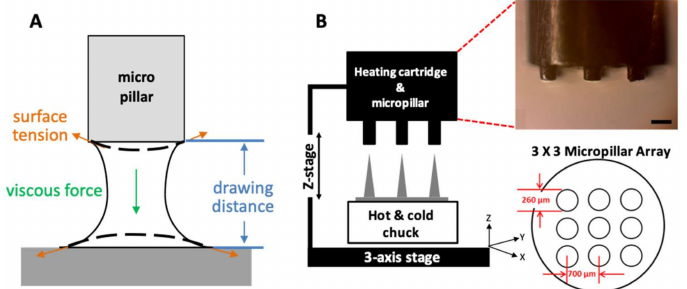
Figure 1. ( A ) A schematic image of phenomenological variables, including surface tension, viscous force, and drawing distance considered in a three-step thermal drawing system. ( B ) A schematic image of three-step thermal drawing system consisting of a hot and cold chuck and heating cartridge for controlling temperature on both sides; hot and cold chuck on the bottom and heating cartridge on the top. A z-axis stage for the precise control of drawing distance and a micropillar array for contacting and drawing polymeric